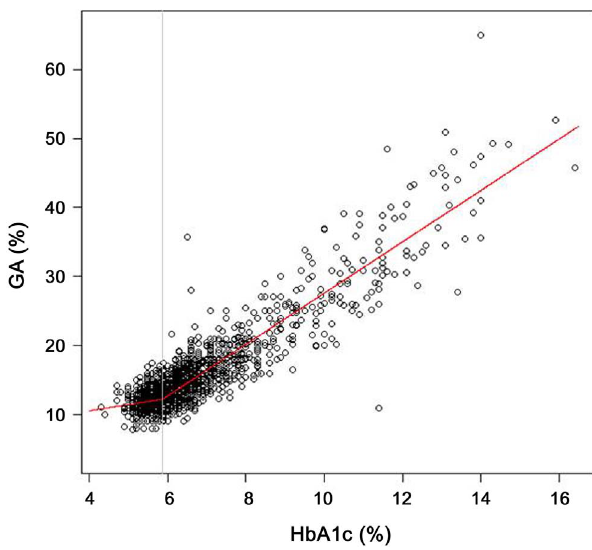
Figure 1. Estimating regression model analysis with unknown break-points.